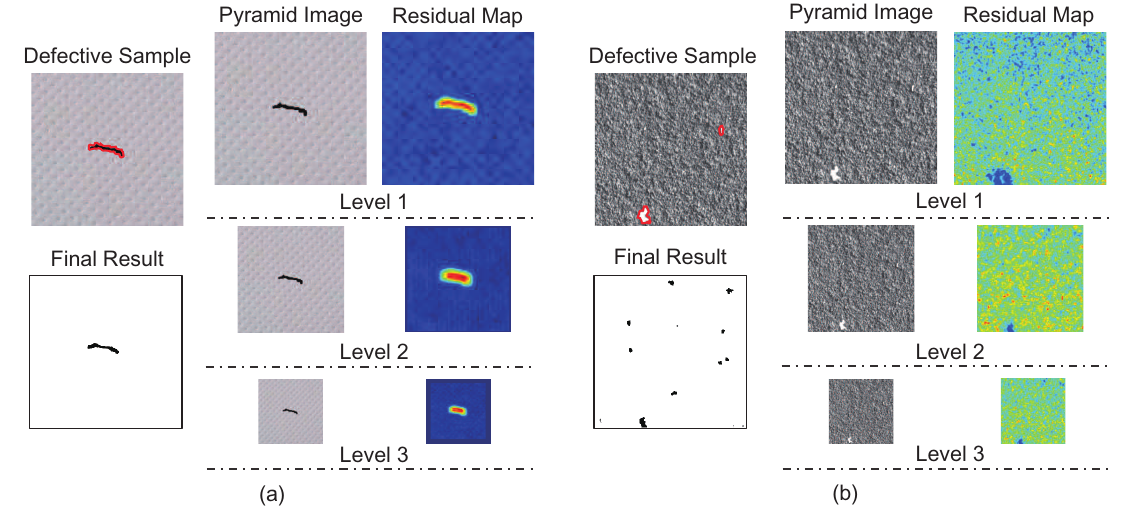
Figure 9. Final and intermediate defect detection results of the proposed MSCDAE model on ( a ) cotton and ( b ) canvas